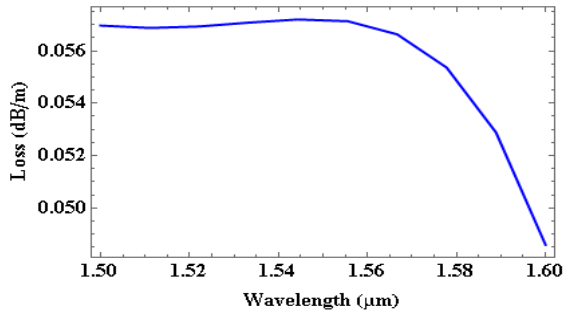
Figure 10. Loss in the waveguide as a function of wavelength.